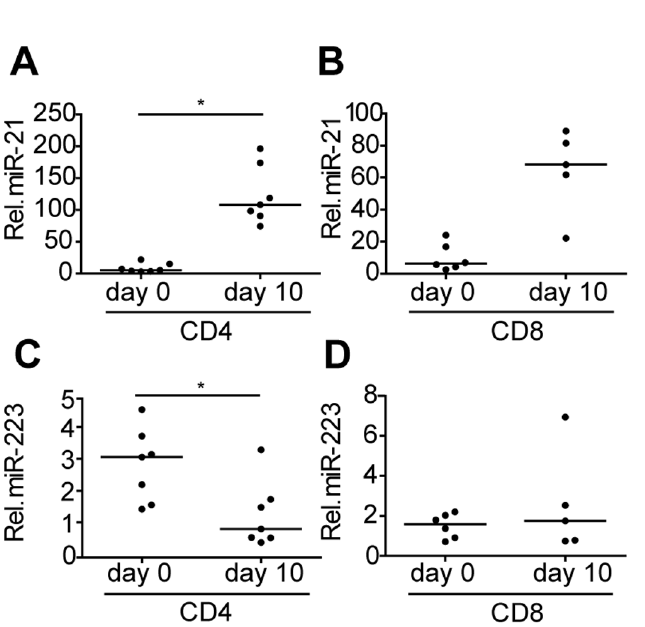
Fig 4. T-cell activation induces upregulation of miR-21 and downregulation of miR-223. Relative expression of miR-21 in stimulated (A) CD4+CD45RO- and (B) CD4-CD45RO- T cells. Relative expression of miR-223 in stimulated (C) CD4+CD45RO- and (D) CD4-CD45RO- T cells. MiRNA expression was normalized to the expression of RNU49 (line indicates median). * p < 0.05.